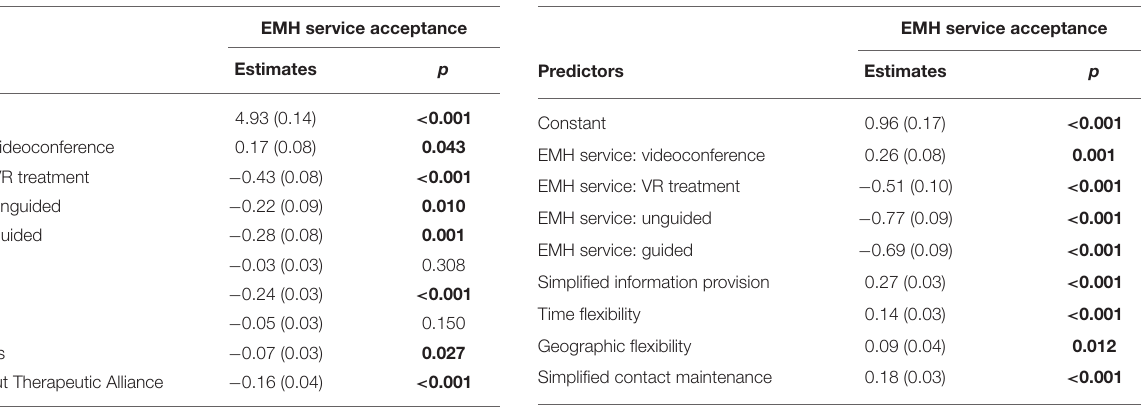
TABLE 3 | Estimates of barriers to the acceptance of EMH services. TABLE 4 | Estimates of drivers to the acceptance of EMH